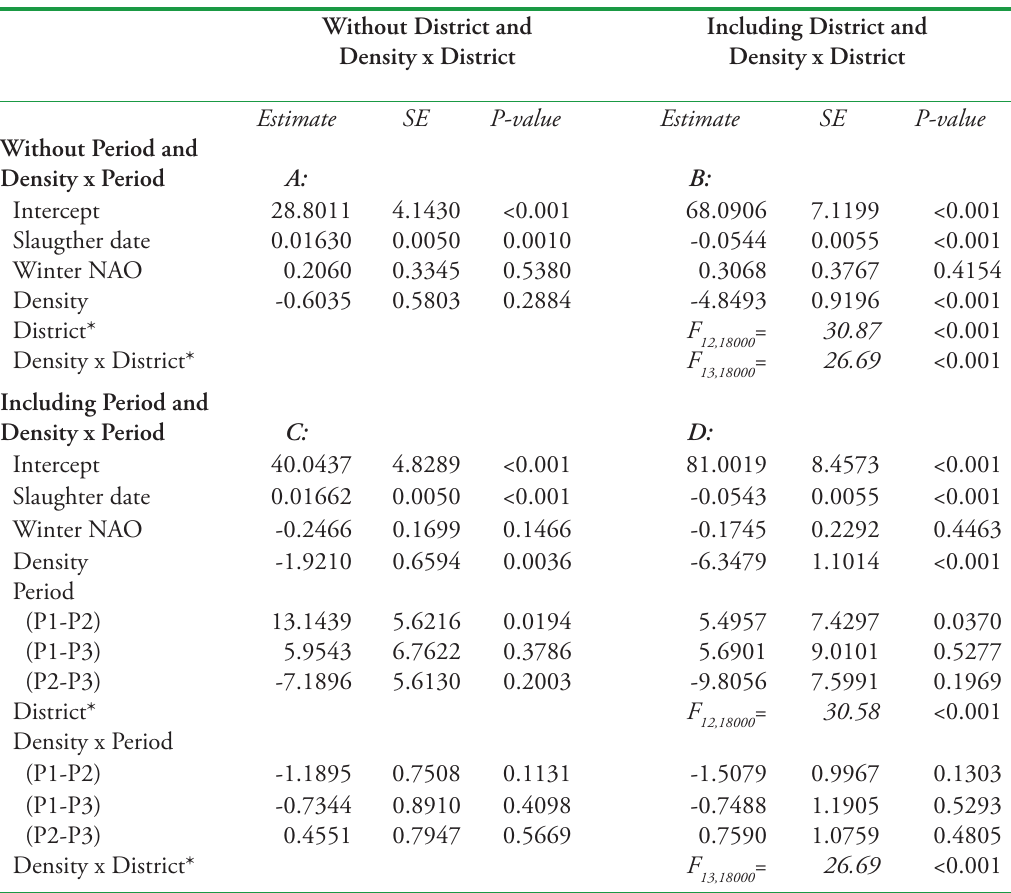
Table 3. Parameter estimates with standard errors (SE) and P -values for the mixed linear models fitting the autumn carcass masses (in kg) of male yearlings at the medium density scale (i.e. mainland ) without district and period and theirs interactions with density ( A: ), including district within the sub-region and density by district interaction ( B: ) (for the main effect and the interaction the ANOVA results are presented in italic), with period (P1: 1983-86, P2: 1996-2001; P3: 2002-2004) and density by period interaction ( C: ), and including district and period and theirs interactions with density ( D: ). Slaughter date and winter NAO are entered as covariates in the